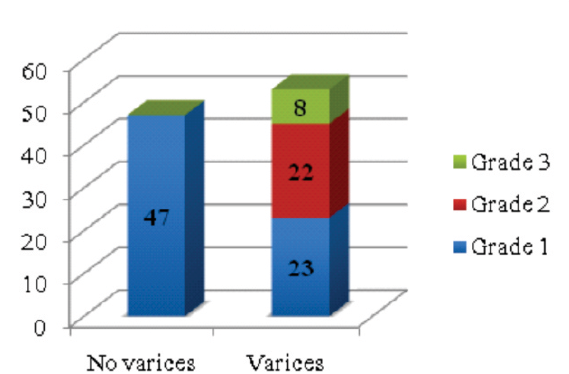
Chart 1: Bar diagram showing different grades of esophageal varices